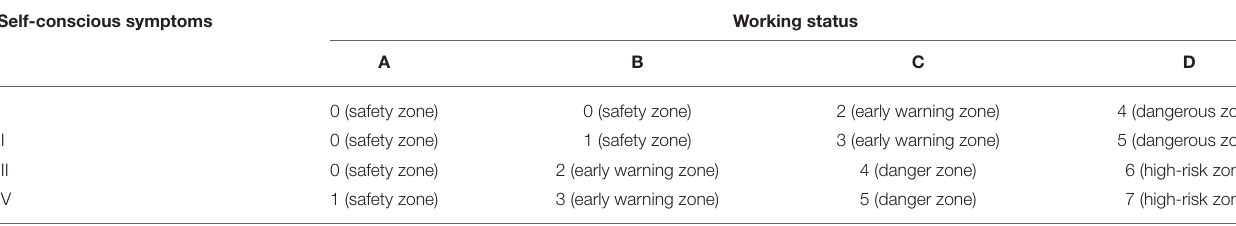
TABLE 1 | Score of IDS riders’ overwork (Work Burden Index). Self-conscious